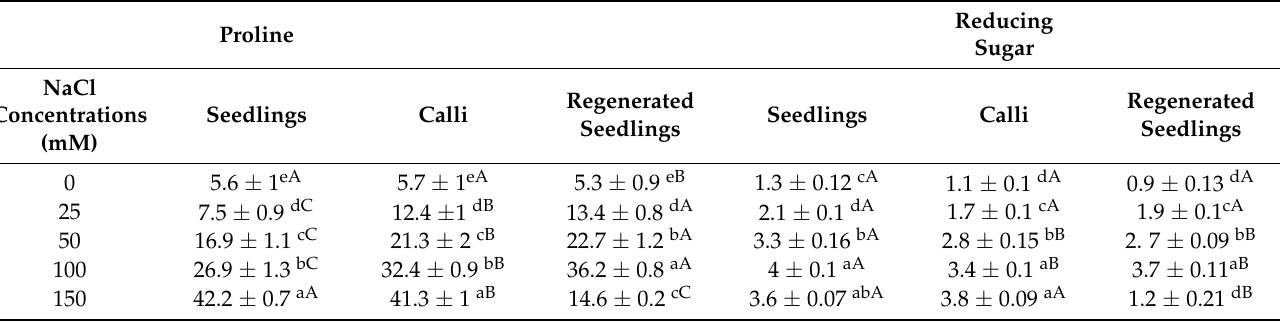
Different lowercase letters within a column indicate significant differences among the 5 NaCl concentrations in an explant of Carum copticum (Duncan’s test p ≤ 0.05); Different uppercase letters within a row indicate significant differences among 3 explants of Carum copticum within the same NaCl level (Duncan’s test p ≤ 0.05). Each value represents the mean of three replicates ± standard